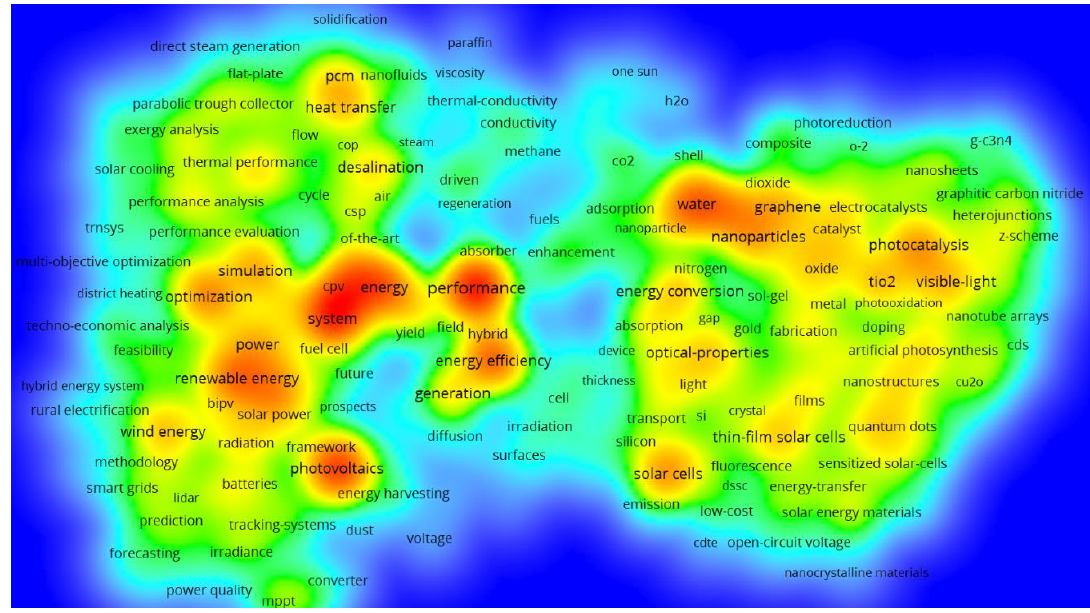
Figure 10. Hot topics in Solar Energy research in 2011–2020 (1% most common